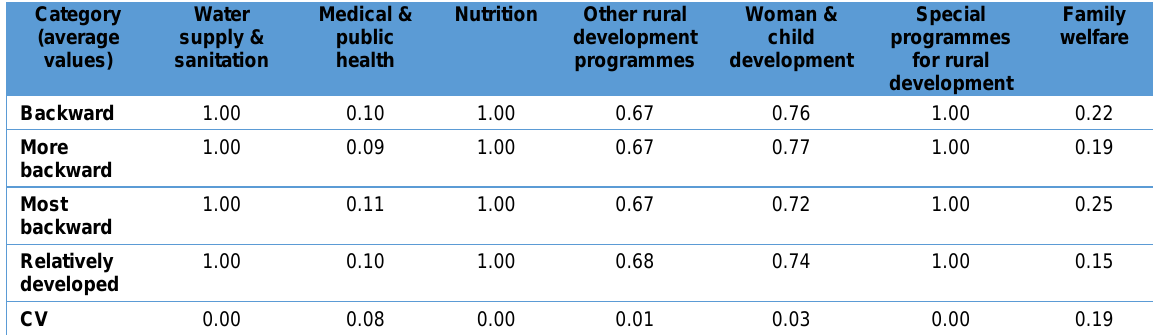
Table 1: LCA and its variability across different district categories (relative measures – ratios) Category (average values)